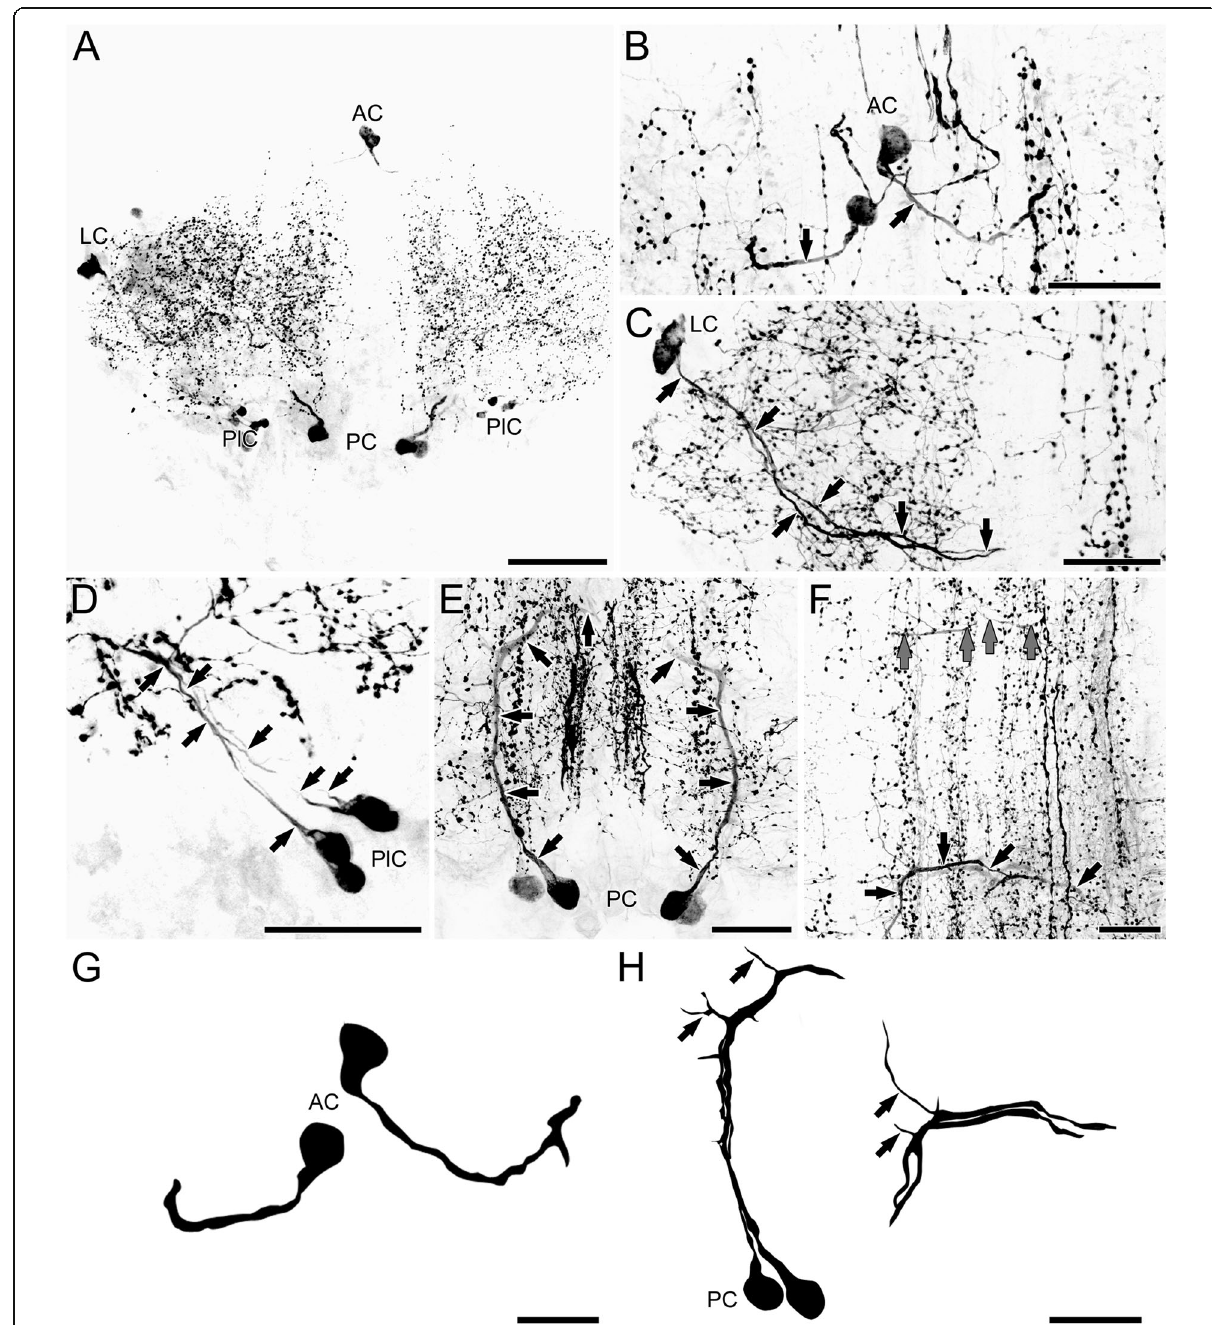
Fig. 5 Distribution of 5HT-ir neurons in the VNC of Scolopendra oraniensis . All neurons were detected in every ganglion of all preparations. a These individually identifiable neurons can be distinguished according to somata positions within the ganglia into anterior (AC), lateral (LC), postero-lateral (PlC), and posterior cells (PC). b The initial projection of the ACs could been followed only for a short distance (arrows, but see f). c The LC project their neurites slightly posteriorly and medially towards the midline before the microscopic signal got lost (arrows). d Neurites of the PlC could only be traced for a short distance, projecting antero-laterally (arrows). e The pair of PCs project their processes anteriorly, before turning medially (arrows). f Contralateral projections could be detected in the anterior (gray arrows) and posterior parts (black arrows) of the ganglia at the level of the ACs and PCs, respectively. Compare also Fig. 6. g Reconstructions of ACs B. h Reconstructions of PCs (left) and its respective contralateral projections (right). Note that tracings were produced from different vibratome sections; arrows point to corresponding branching neurites. Compare also Fig. 6. Scale bars: A = 100 μ m; B – F,H = 50 μ m; G = 25 μ